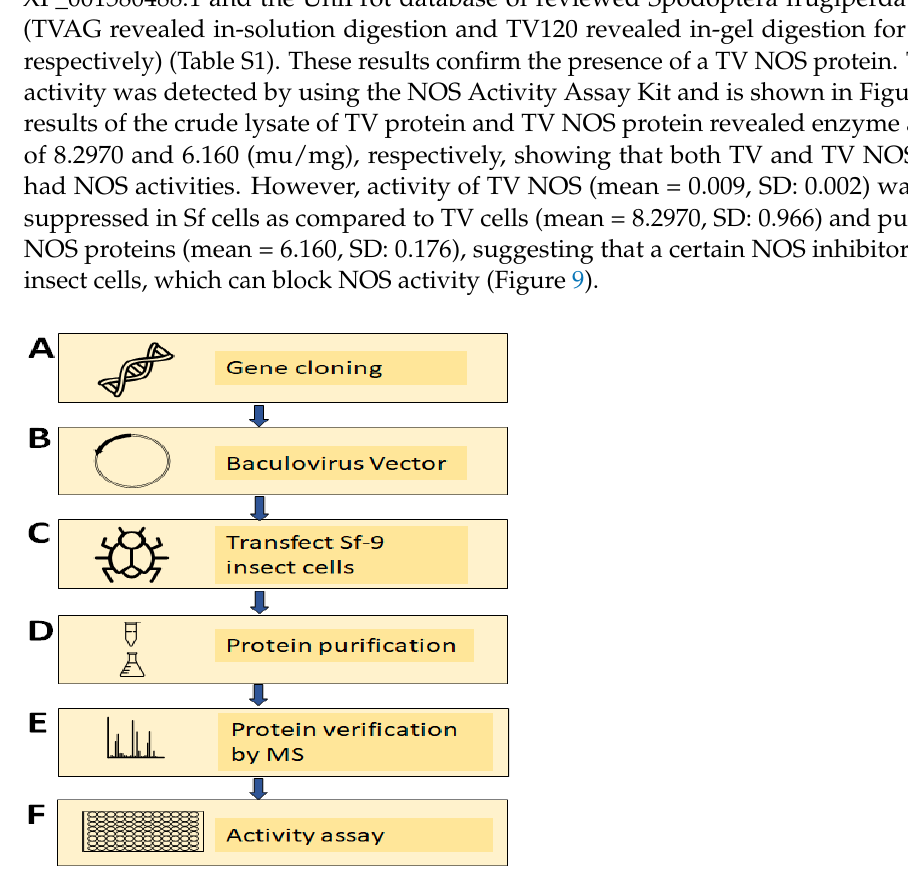
Figure 6. Diagram illustrating the serial experimental steps to validate TVAG_136330 as a nitric oxide synthase in TV, including ( A ) cloning of TVAG_136330 by using a PCR-based accurate synthesis method, ( B ) subcloning of TVAG_136330 to the baculoviral vector, ( C ) transfection of sf-9 insect cells with the baculoviral vector to generate virus, ( D ) transduction of insect cells with viruses to overexpress proteins and performing protein purification, ( E ) verification of protein sequence by mass spectrometry, and ( F ) verification of NOS activity in purified TVAG_136330 proteins.